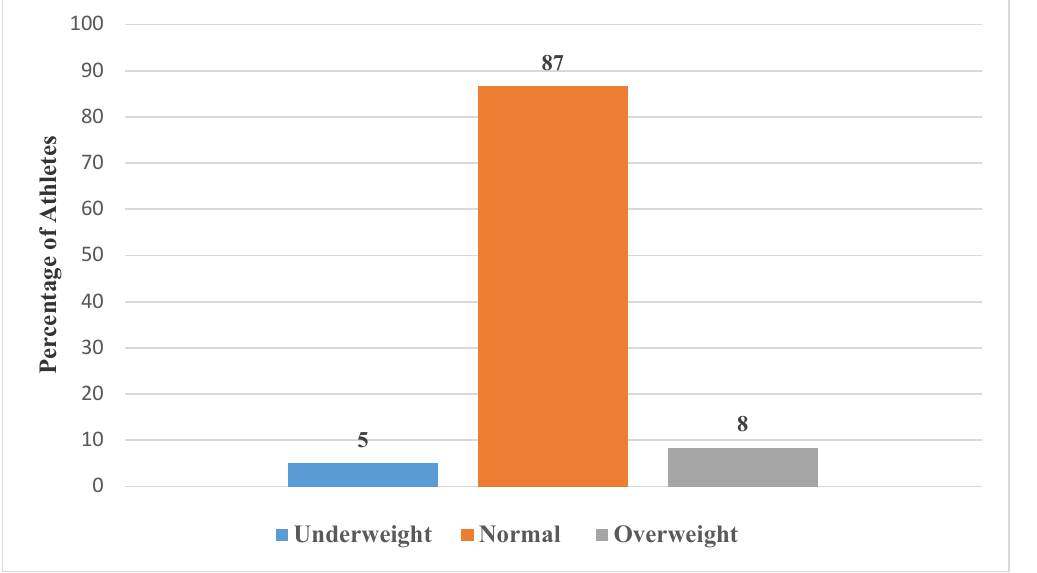
Figure 3. Anthropometry of athletes.